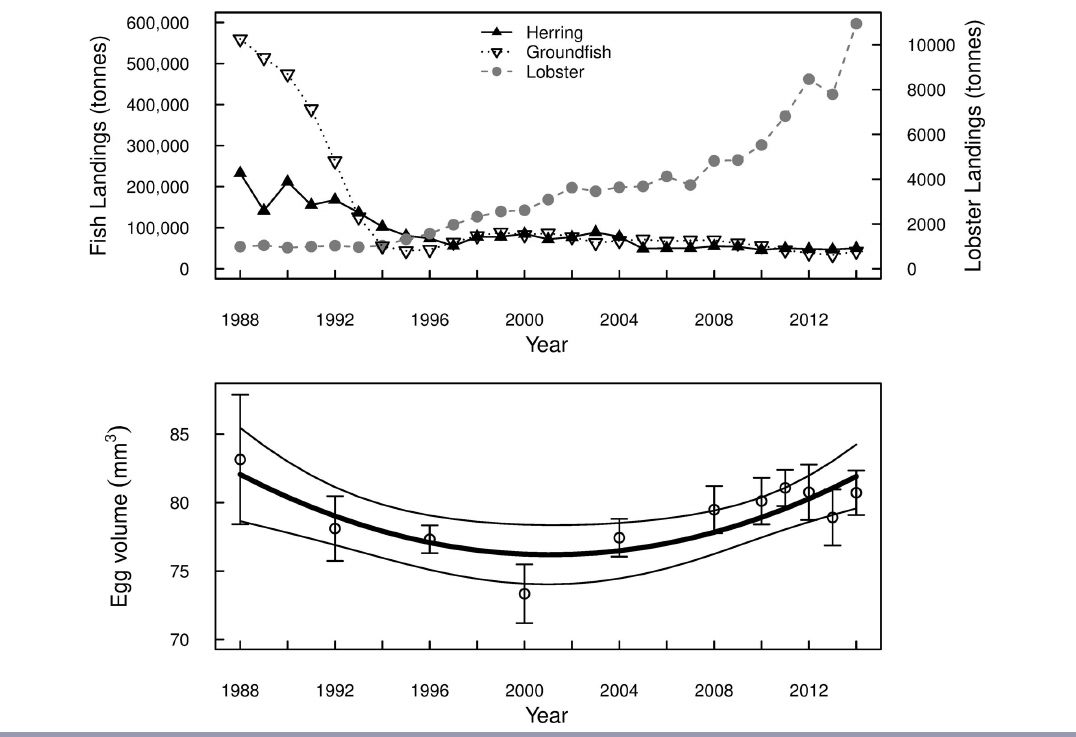
Fig. 2 . Relationships between commercial fisheries landings (a) and average Herring Gull ( Larus argentatus ) egg volume from Kent Island (b) between 1988 and 2015. Fisheries landings include Atlantic Herring ( Clupea harengus ; zone 4WX, Southwestern Nova Scotia and Bay of Fundy portion), American Lobster ( Homarus americanus ; Lobster Fishing Areas 35-38), and total Groundfish (cod, hake, and haddock; Atlantic Canada). Axes for tonnage of landings vary by fisheries because they are reported from raw data from different areas; they reflect regional trends in fisheries activity but do not reflect local landings around the study area. Egg measurements were obtained from collections by Environment and Climate Change Canada, which sampled 1 egg from each of 5 nests in 1988 and 1 egg from each of 15 nests every 1 to 4 years between 1992 and 2015 (Burgess et al. 2013). See methods for details on data